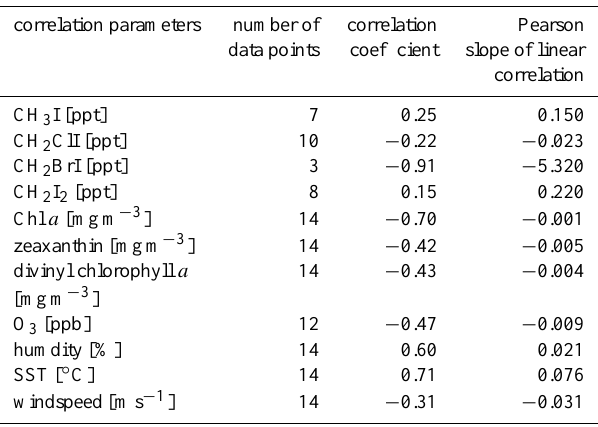
Table 5. Overview of the correlation of different parameters with IO mixing ratios (daily averages).